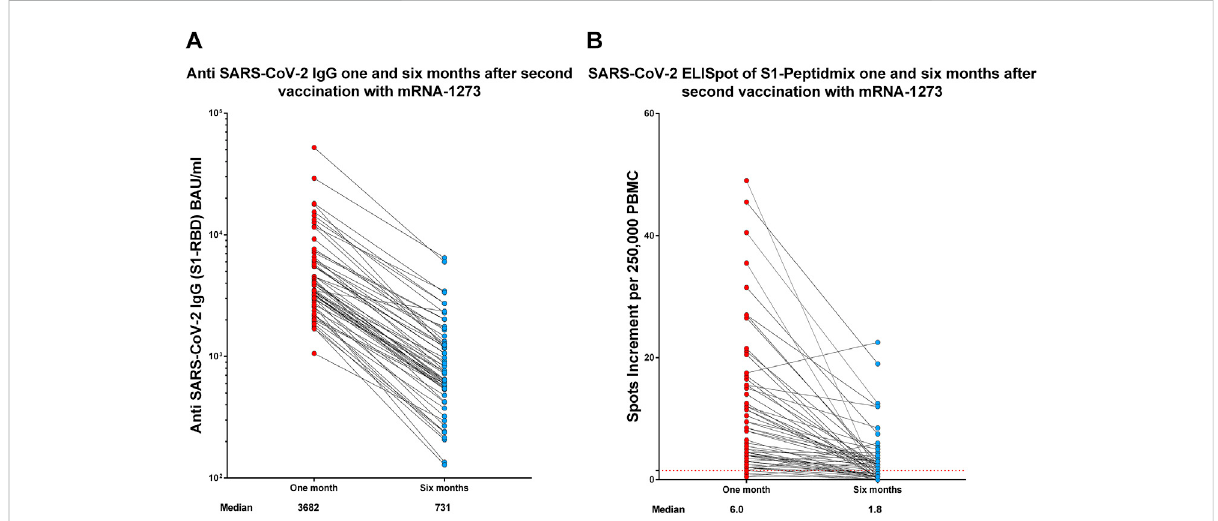
FIGURE 2 Humoral (A) and cellular (B) immune response 1 and 6 months after the second vaccination with mRNA-1273 in the group of 64 participants whowereavailableatbothtime points. Antibody titers arereportedinBAU/ml andT-cell responseas spotsincrement. Red dashedlines indicatethe cut-off for positivity (1.5 spots increment per 250,000 peripheral blood mononuclear